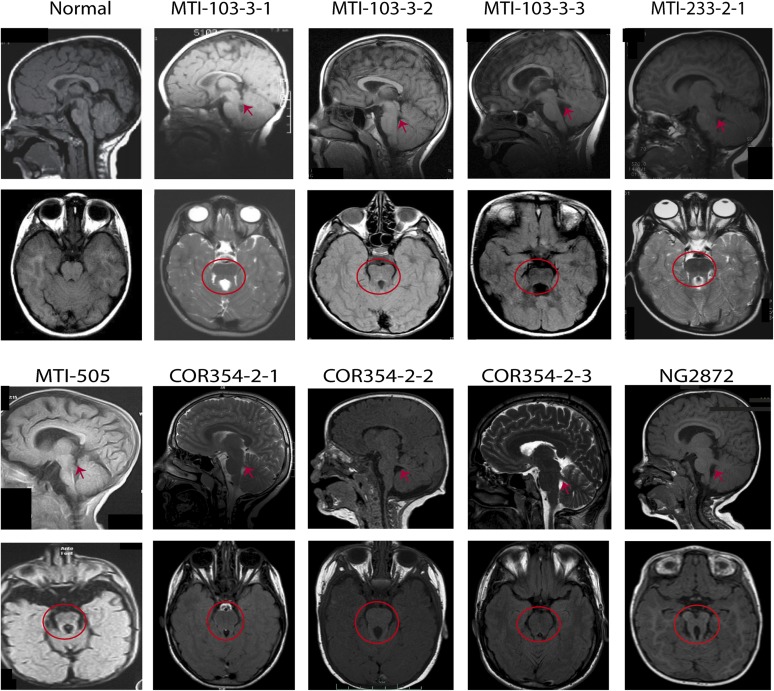
MRI scans from patients with KIAA0586 mutations.Magnetic resonance imaging (MRI) in a healthy individual and patients with KIAA0586 mutations showing thickened and mal-oriented superior cerebellar peduncle (upper, red ‘arrowheads’), deepened interpeduncular fossa and constituting the ‘molar tooth sign’ (red circle). In COR-354-2-3, the molar tooth sign was very mild, possibly due to suboptimal image averaging. Figure 3—figure supplement 1 shows the imaging phenotype of affected JS individual MTI-1944-2-1.